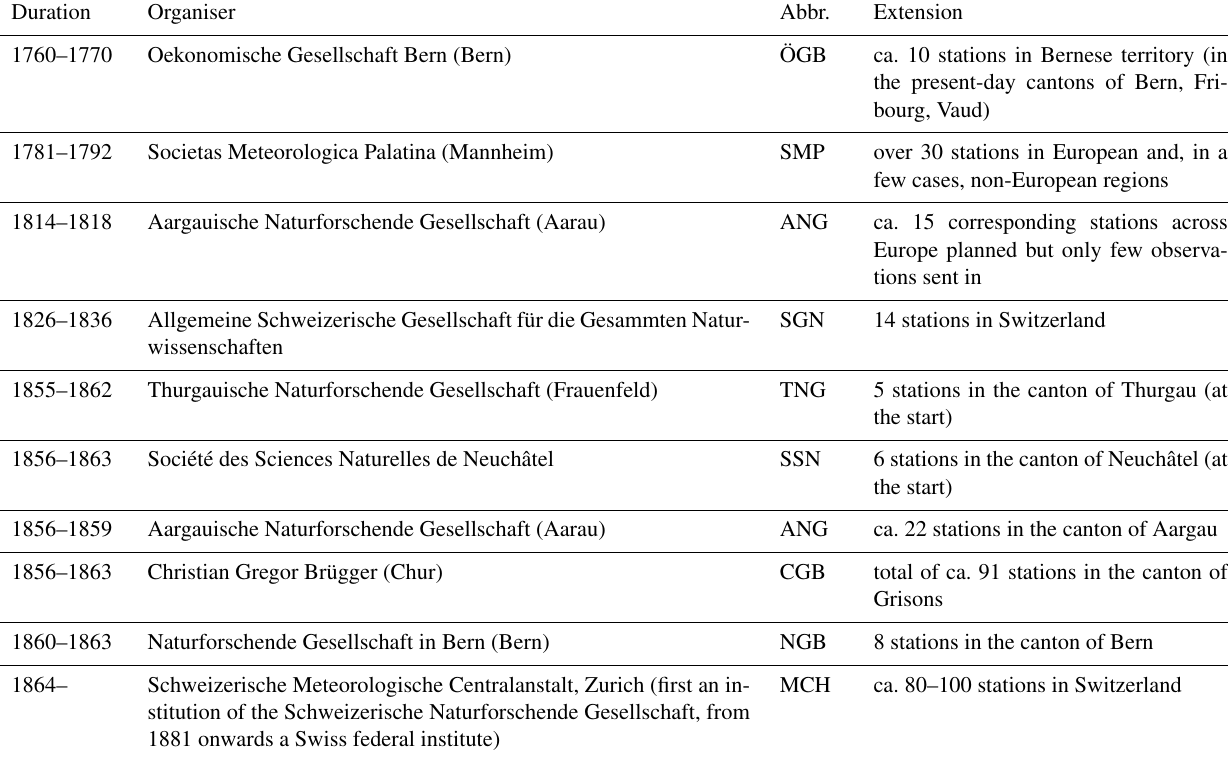
Table 1. Meteorological networks with stations in the territory of today’s